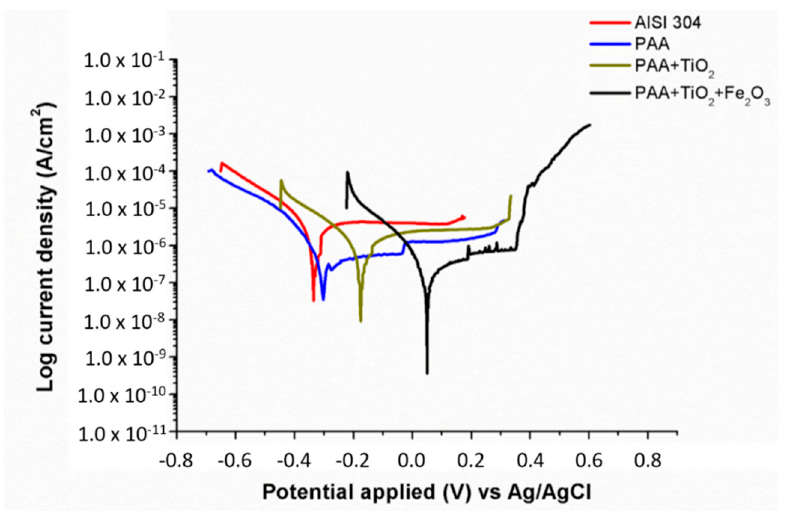
Figure 10. Tafel plots for the reference AISI 304 substrate and for the different samples coated with electrospun fibers in 3.5 wt% NaCl aqueous solution. Table 1. The electrochemical parameters from Tafel polarization curves for bare stainless steel (AISI 304) and the coated reference substrate with all the electrospun coatings in 3.5 wt% NaCl aqueous solution.